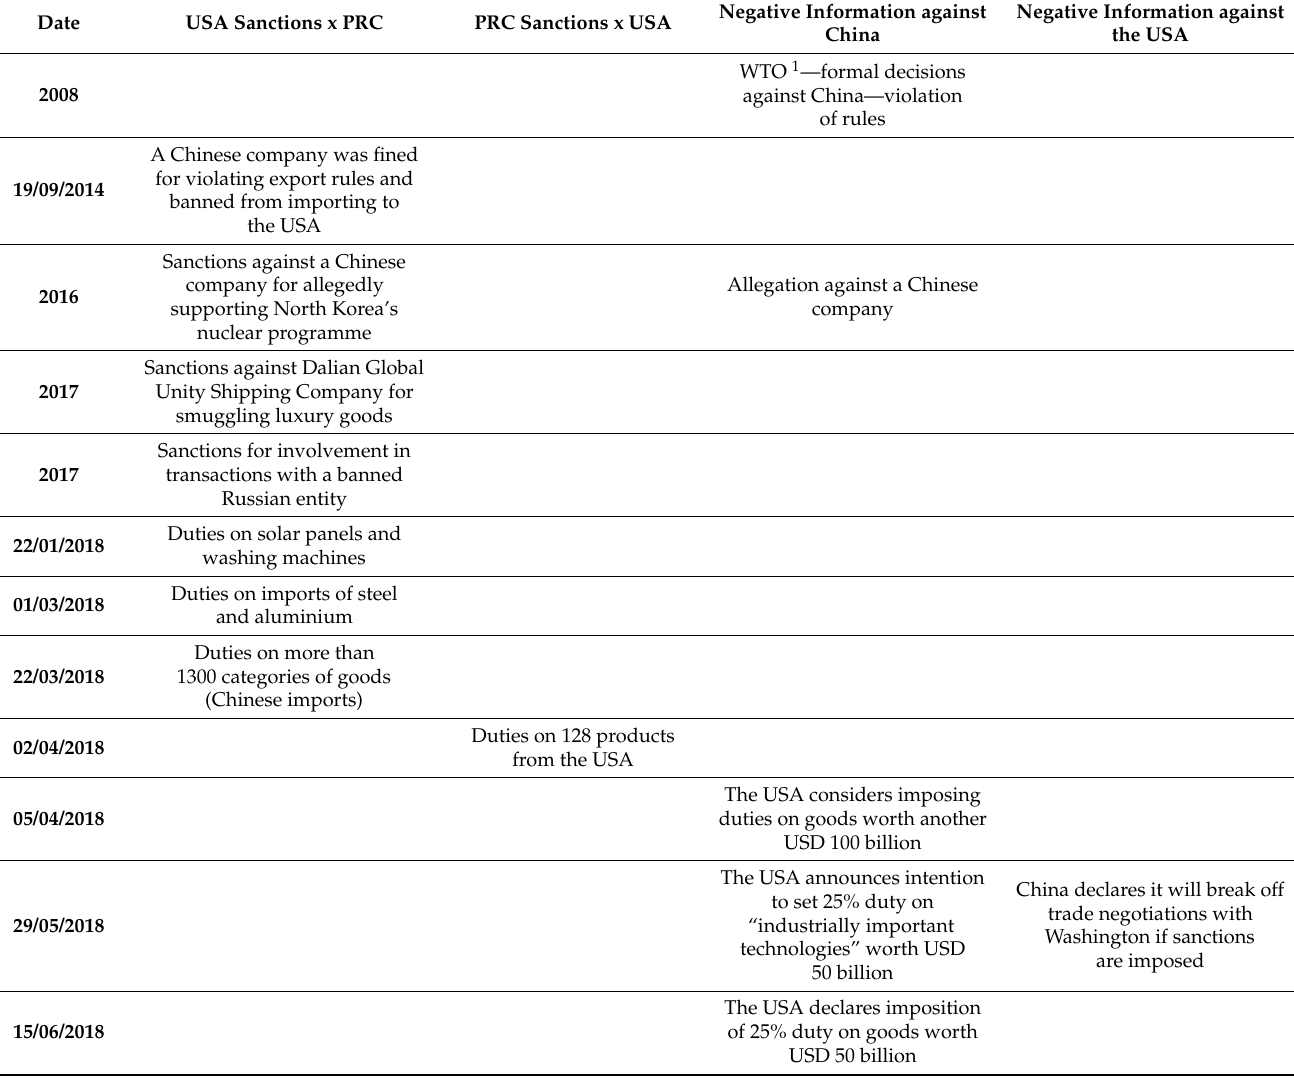
Table A1. Overview of important measures implemented in the trade war between the USA and the